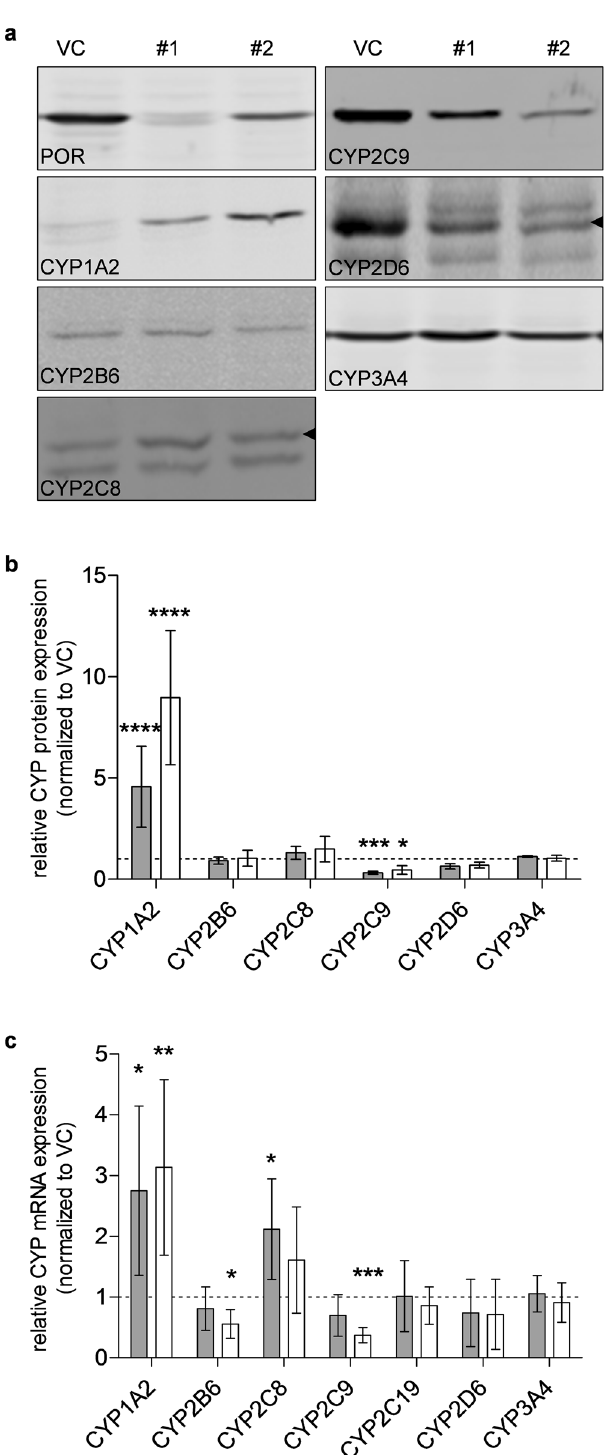
Figure 6. CYP expression analysis in HepaRG -POR microsomes or cell lysates. ( a ) Exemplary Western Blots of microsomal fractions of HepaRG cells transduced with vector control (VC) or sgRNAs POR#1 or POR#2 after differentiation for 3 weeks (see Supplementary Fig. S2 online for full blots). ( b ) Means ± SD of protein expression data of CYP1A2, CYP2B6, CYP2C8, CYP2C9, CYP2D6 and CYP3A4 of 4 independent preparations are shown relative to VC set to 1.0. Statistical significance was assessed by unpaired t-test. ( c ) Gene expression analysis of CYP1A2, CYP2B6, CYP2C8, CYP2C9, CYP2C19, CYP2D6 and CYP3A4 in HepaRG cells transduced with sgRNAs POR#1 and POR#2 and vector control (VC) and differentiated for 2 weeks was performed by qPCR. Data of 6 independent experiments were normalized to the geometric mean of GAPDH, RPLP0 and β-actin. Statistical significance was assessed by paired t-test (* p < 0.05, ** p < 0.01, *** p < 0.001, **** p <